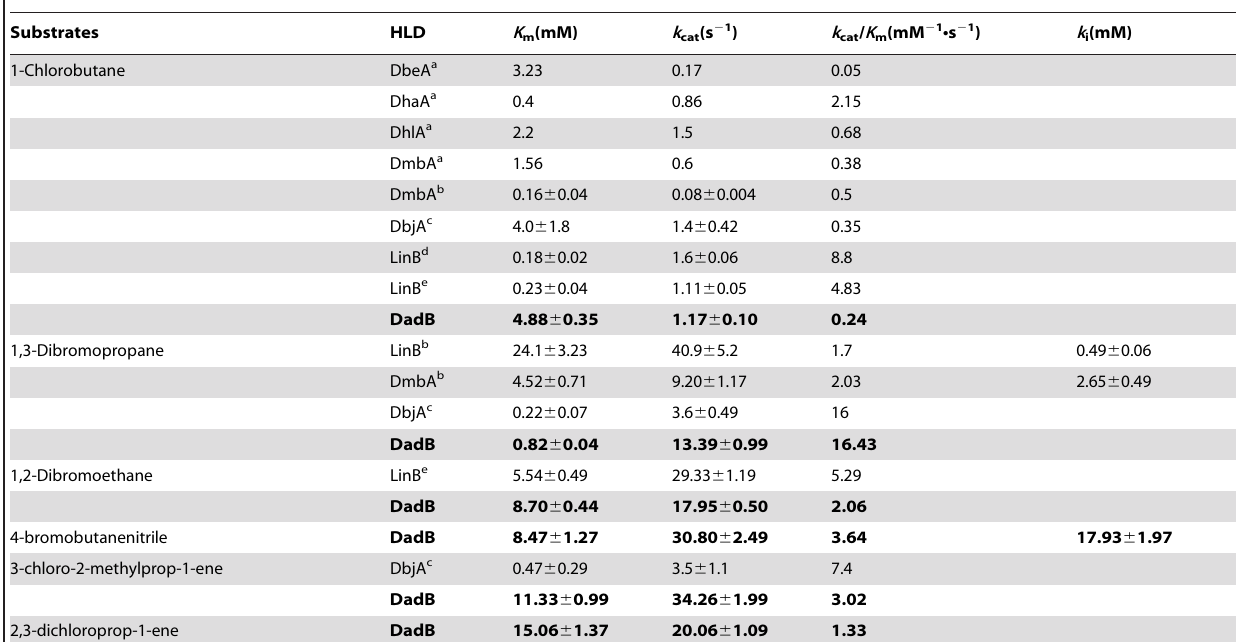
Table 2. Kinetic parameters of DadB and other HLDs.